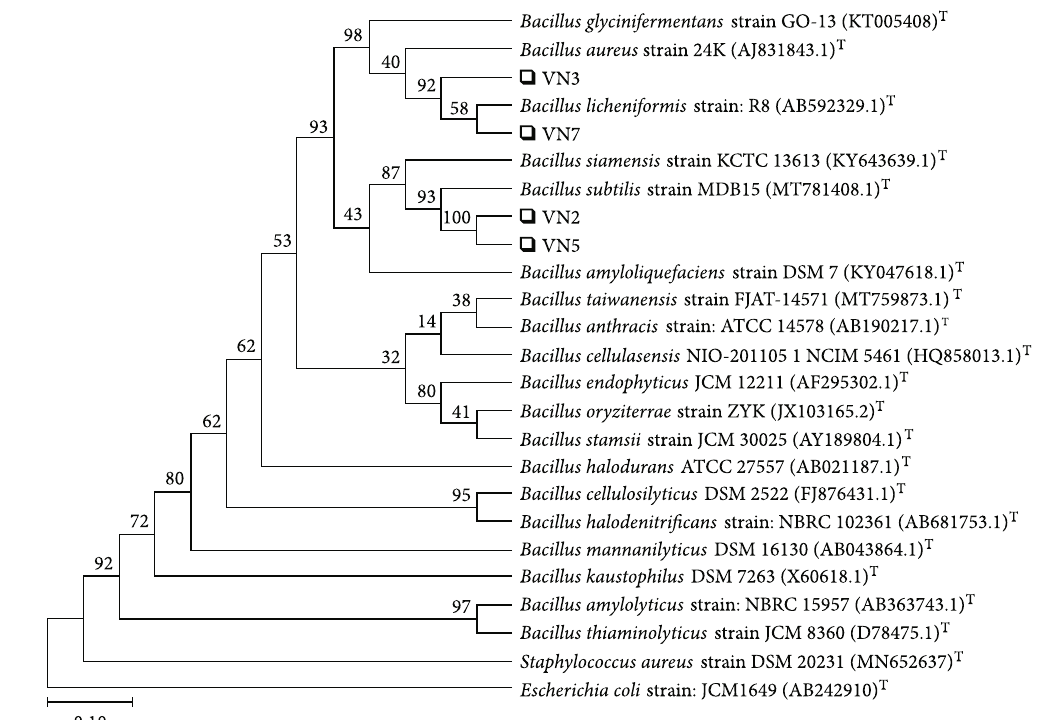
Figure 2: Phylograms of 16S rRNA sequence-based phylogenic trees of VN2, VN3, VN5, and VN7.